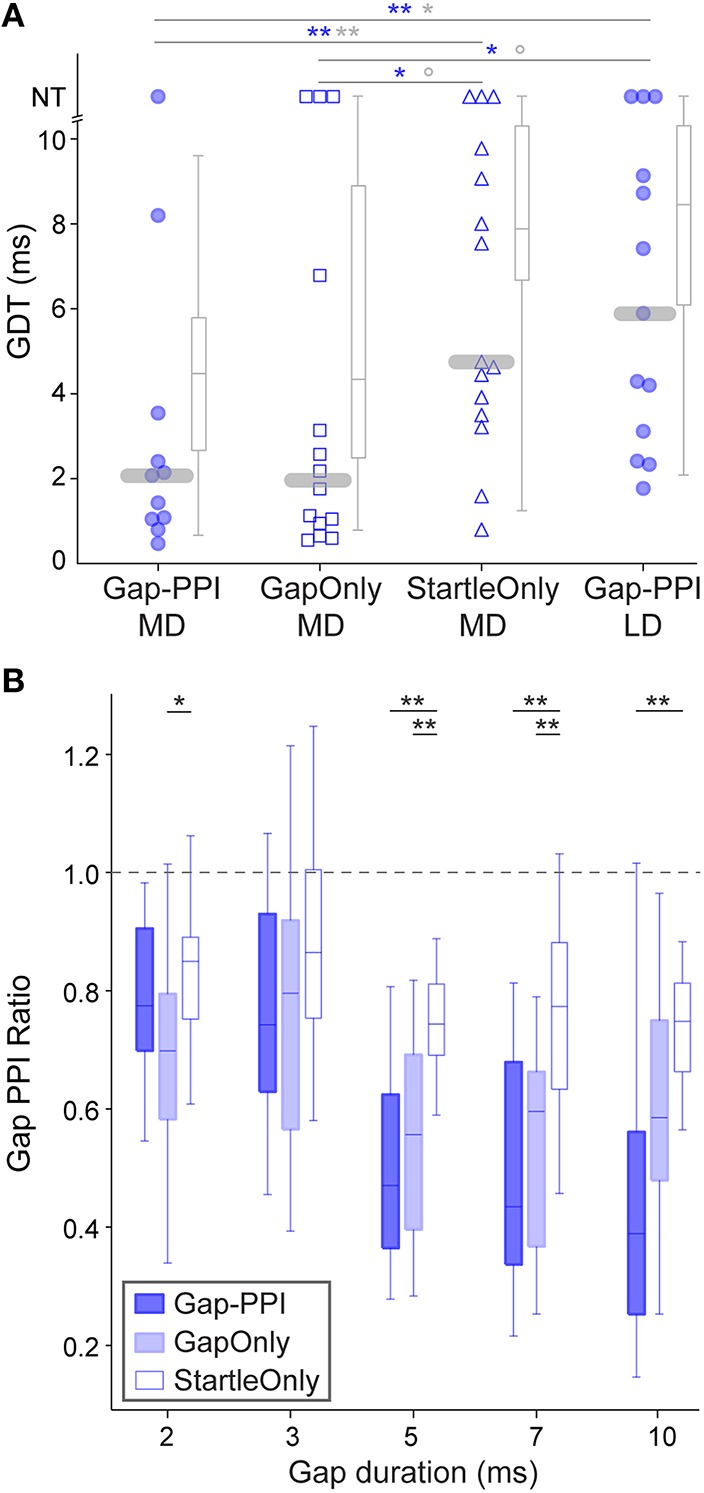
Responses of age-matched animals that experienced various exposure regimens. (A) Symbols depict best GDTs and gray boxplots depict average GDTs from two testing sessions in individual age-matched (P38-42) animals; age-matched sessions are those which are gray-shaded in Figure 1B. Gap-PPI LD animals were the naïve age-matched controls for the other groups which received different exposure regimens for three sessions prior to testing (gap-PPI, gap-only, or startle-only). Gap-PPI exposure and Gap-Only exposure were equivalently effective in reducing GDTs. Startle-Only exposure did not reduce GDTs, and their GDTs were equivalent to inexperienced Gap-PPI LD controls. NT = no threshold, indicating that the longest gap presented (10 ms) was not detected. Blue and gray significance symbols refer to best and average GDTs, respectively. **p < 0.02; **p < 0.05; °p < 0.1 (B) Response ratios across gap durations, normalized to startle-only responses (dotted line). The Gap-PPI and Gap-Only groups did not differ at any gap duration, while the Startle-Only group differed from either of these groups at most gap durations. **p < 0.007; *p < 0.03.